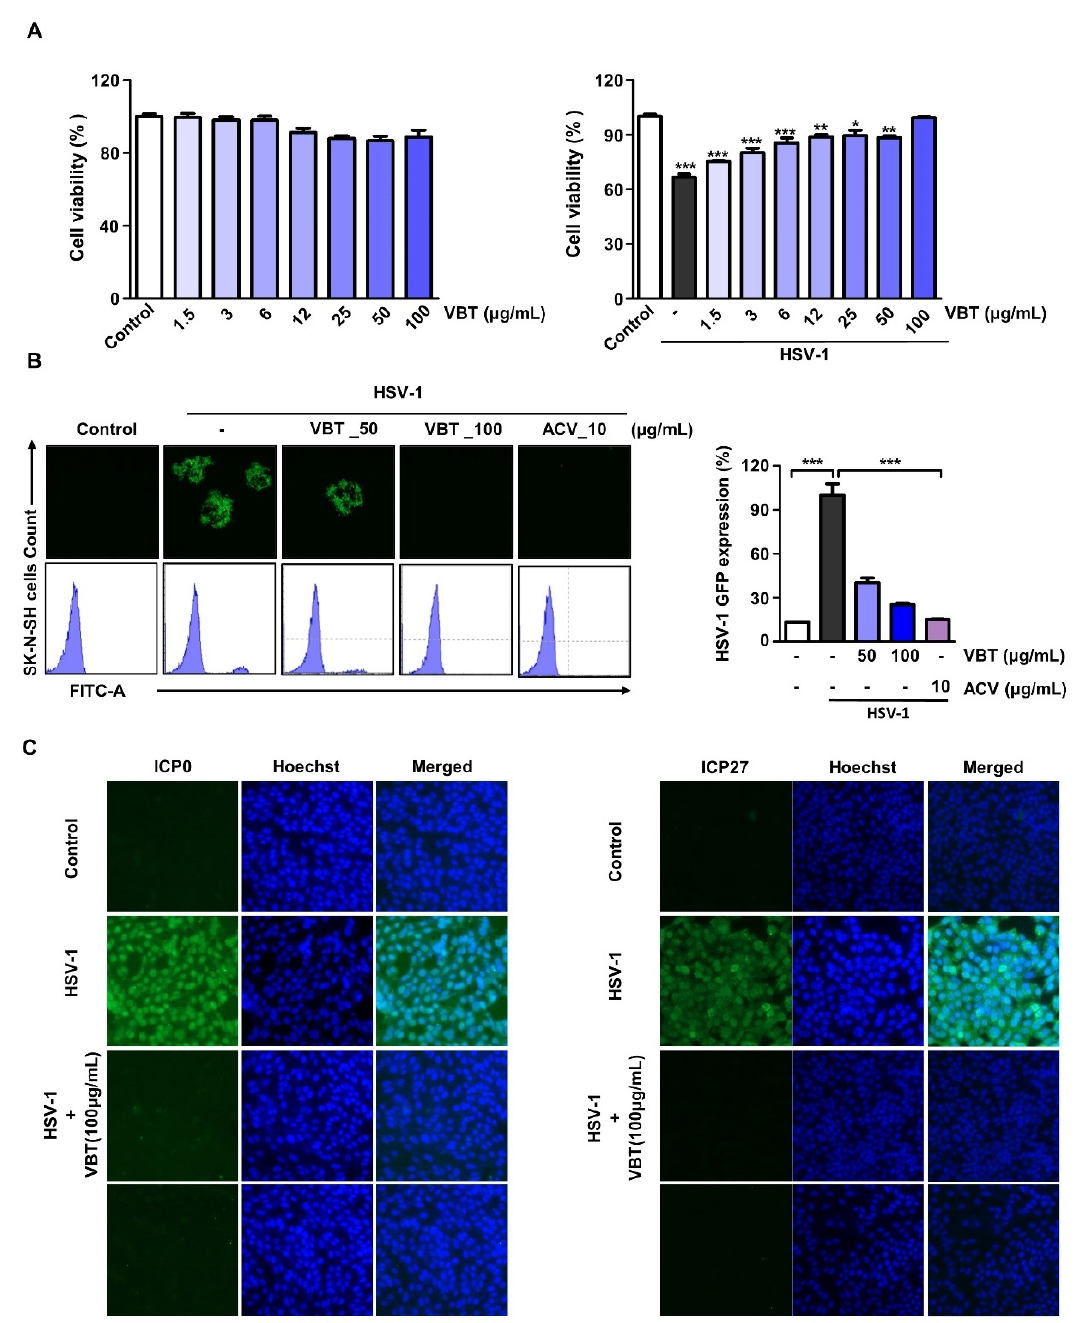
Figure 3. Anti-HSV-1 activity of VBT in SK-N-SH cells. ( A ) SK-N-SH cells were treated with VBT at the indicated concentrations and incubated for 48 h ( Left ). The SK-N-SH cells were infected with HSV-1 (MOI = 0.1) for 2 h ( right ), then replaced with fresh medium, treated with VBT at the indicated concentration, and incubated for 48 h. Cell viability was measured using CCK-8 assays. ( B ) The SK-N-SH cells were infected with HSV-GFP (MOI = 2) for 2 h and then treated with VBT (50 μ g/mL and 100 μ g/mL) and ACV (10 μ g/mL) in fresh medium. Then, after being incubated for 48 h, the HSV-GFP expression levels were analyzed using fluorescence microscopy ( left ) and FACS ( right ). ( C ) ICP0 and ICP27 localization was determined by immunofluorescence assays using a fluorescence microscope. * p < 0.5, ** p < 0.01, *** p < 0.001.